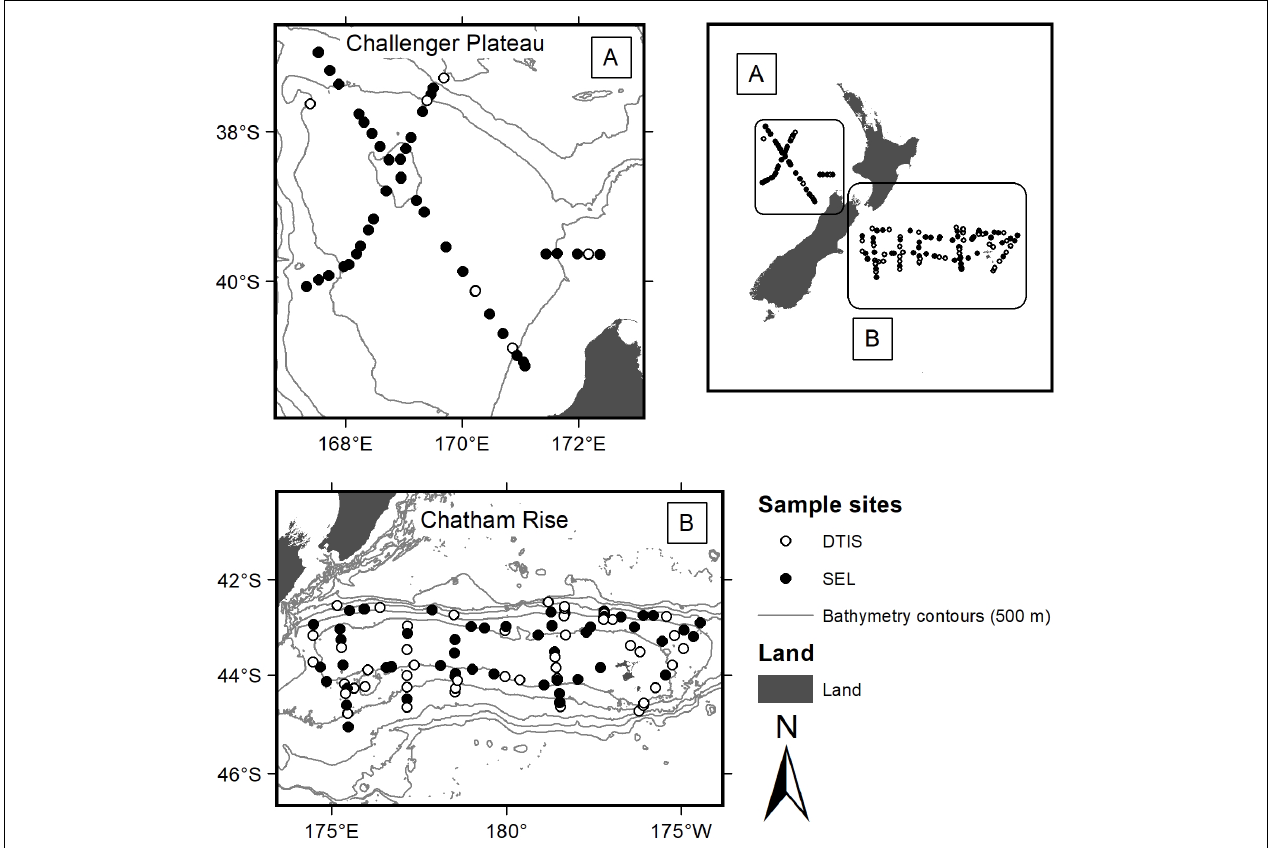
FIGURE 1 | Sites sampled for benthic invertebrate assemblages across Chatham Rise (East of the South Island) and Challenger Plateau (West of the North Island) during Ocean Survey 20/20 voyages TAN0705 and TAN0707. Filled dots were sampled with both DTIS video and SEL epibenthic sleds; open circles were sampled with DTIS video